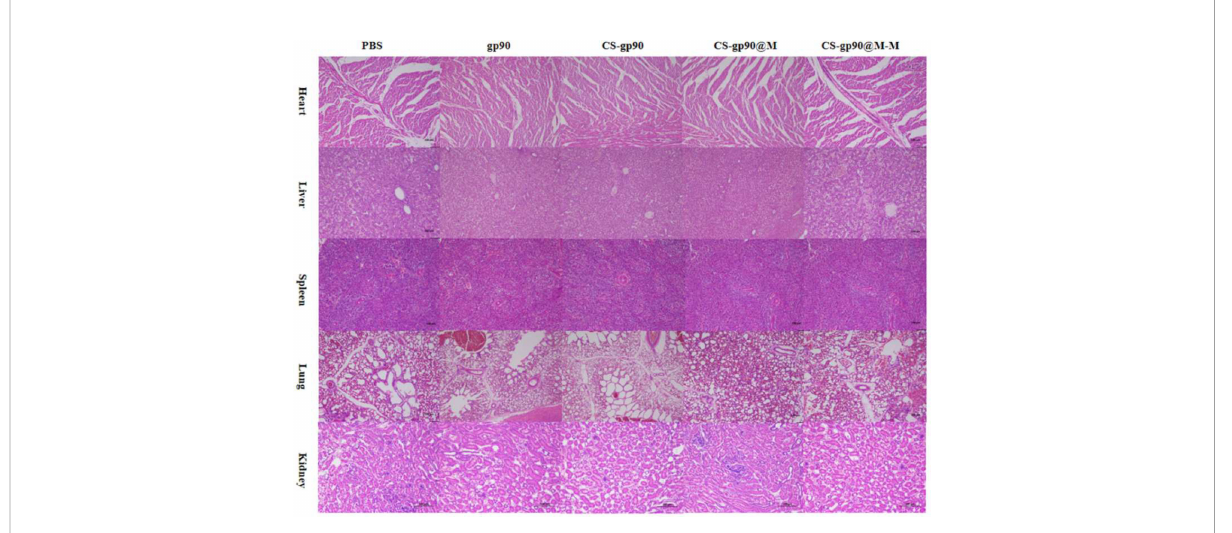
FIGURE 8 Analysis of potential in vivo toxicity. H&E staining of the lungs, heart, spleen, liver, and kidneys of vaccinated chicks on day 28 after immunization. Magni fi cation: 100×, scale bars: 100 m